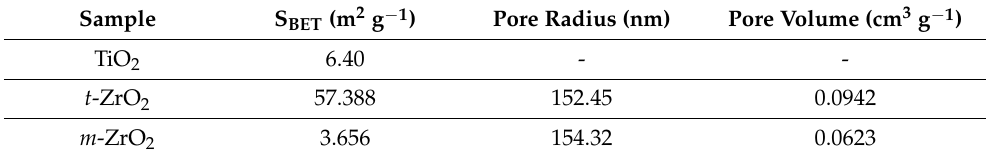
Table 3. Surface area, pore radius, and pore volume of ZrO 2